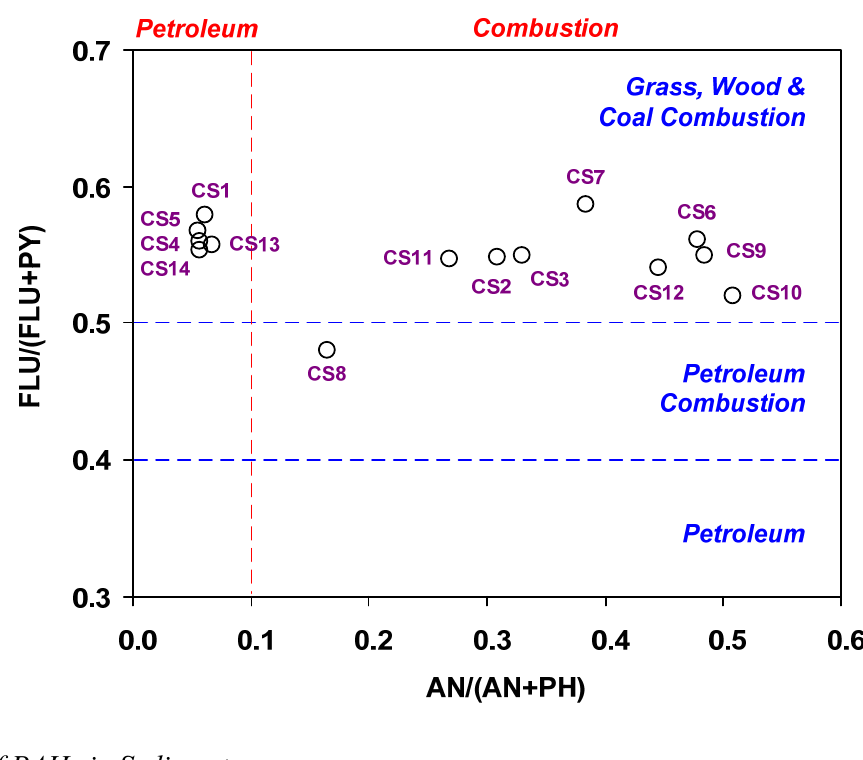
Figure 5. PAHs cross plots for the ratios of FLU/(PY + FLU) vs. AN/(AN +